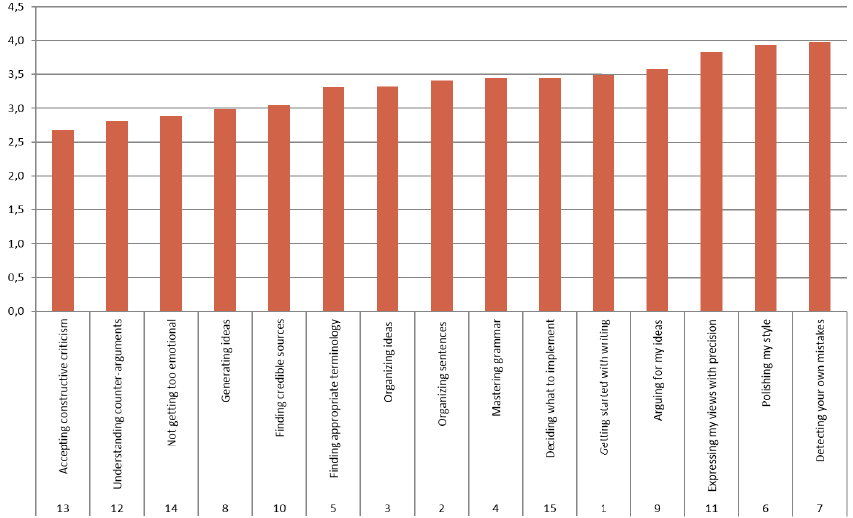
Fig. 2. Thematic priorities based on the quantitative